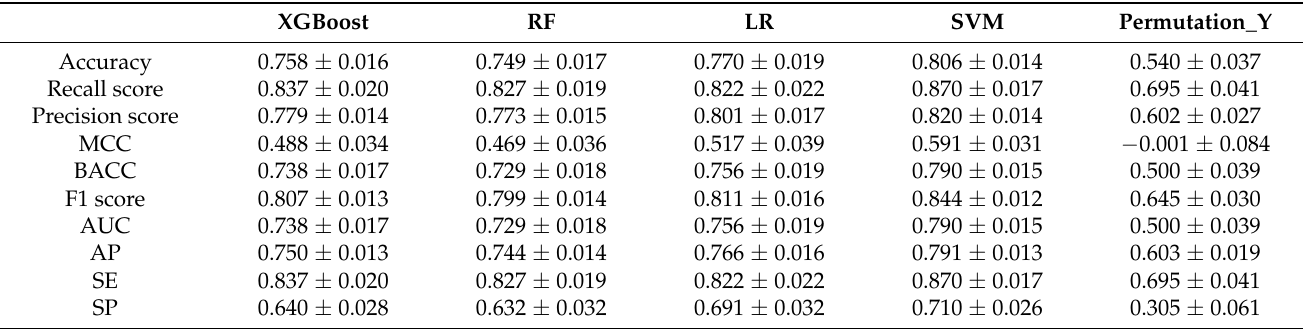
Table 3. Ten of these molecular descriptors as features that were closely associated with the 24 SAs.